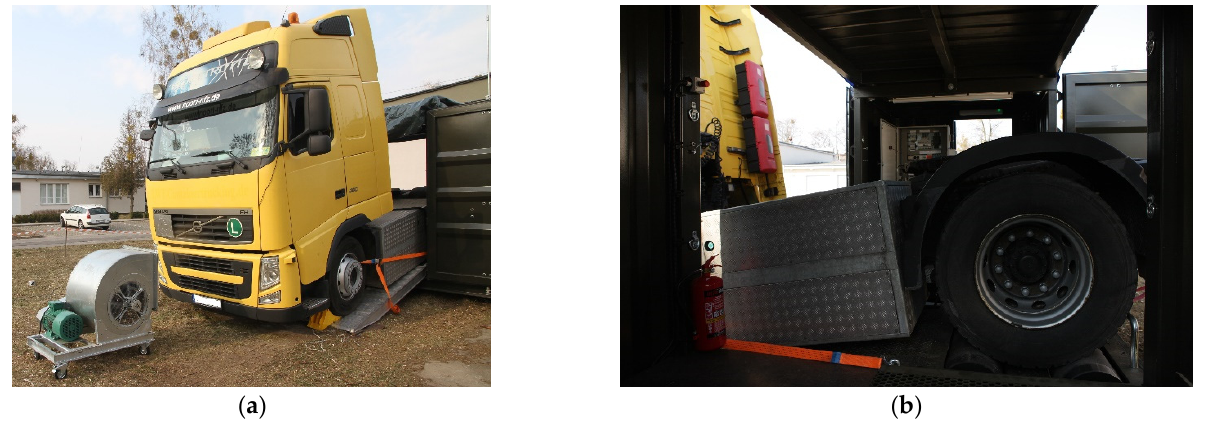
Figure 4. Volvo FH13 on mobile dynamometer: ( a ) front view, ( b ) view of the vehicle drive axle on dyno rollers (authors’ source).